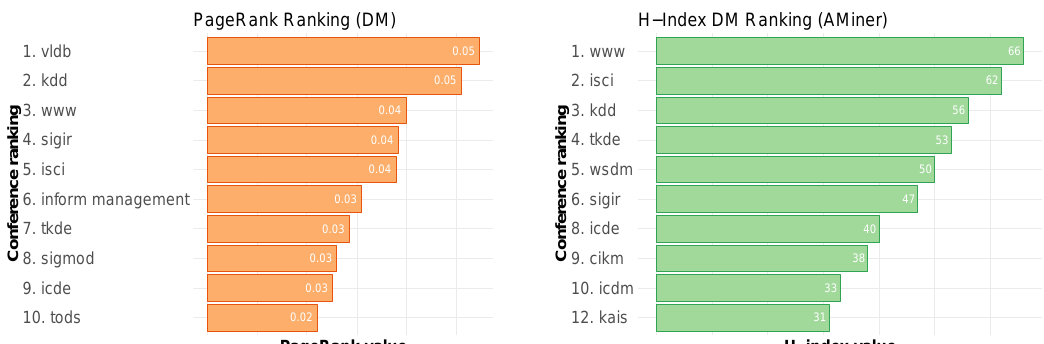
Figure 9. Ranks for AI conferences using PageRank (left) and Aminer H-index (right). Our database does not include some of the conferences present in the original Aminer H-index ranking, hence some positions in H-index ranks are missing.